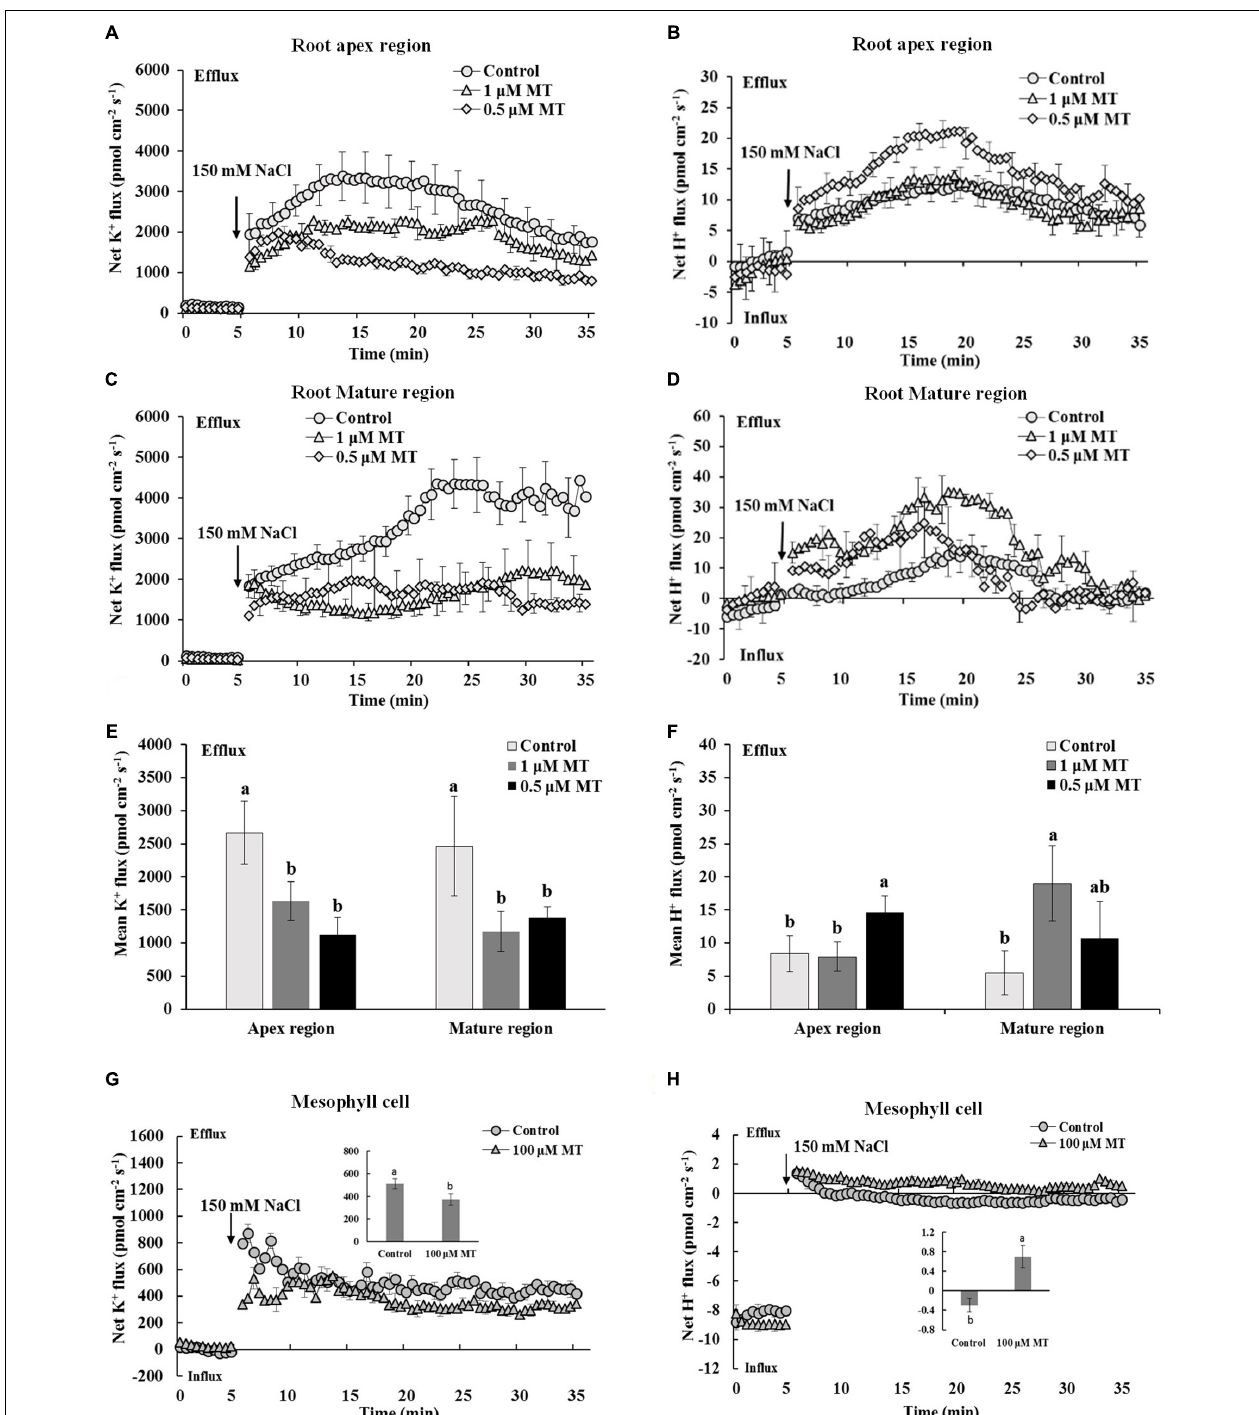
FIGURE 2 | Effects of MT pretreatment on the salt shock-triggered transient K + and H + flux in the root and mesophyll tissue of Xu 32. (A,C) Transient K + flux upon 150 mM NaCl shock in the root apex region (measured at 500 µ m from the tip) and mature region (measured at 15 mm from the tip) of MT-pretreated (0.5 and 1.0 µ M) or non-pretreated seedlings. (B,D) Transient H + flux. (A–D) Each point represents the mean of eight roots at minimum collected from four individual plants. (E,F) Columns show the mean K + and H + flux during the period of NaCl shock ( A–D , approximately 30 min). Different letters denote significant differences at P < 0.05. (G,H) Transient kinetics of K + and H + flux upon 150 mM NaCl shock in mesophyll tissue of MT-pretreated (100 µ M) or non-pretreated seedlings. Each point represents the mean of a minimum of eight replicates. Inserted columns show the mean K + and H + flux during the period of NaCl shock (approximately 30 min). Different letters denote significant differences at P <